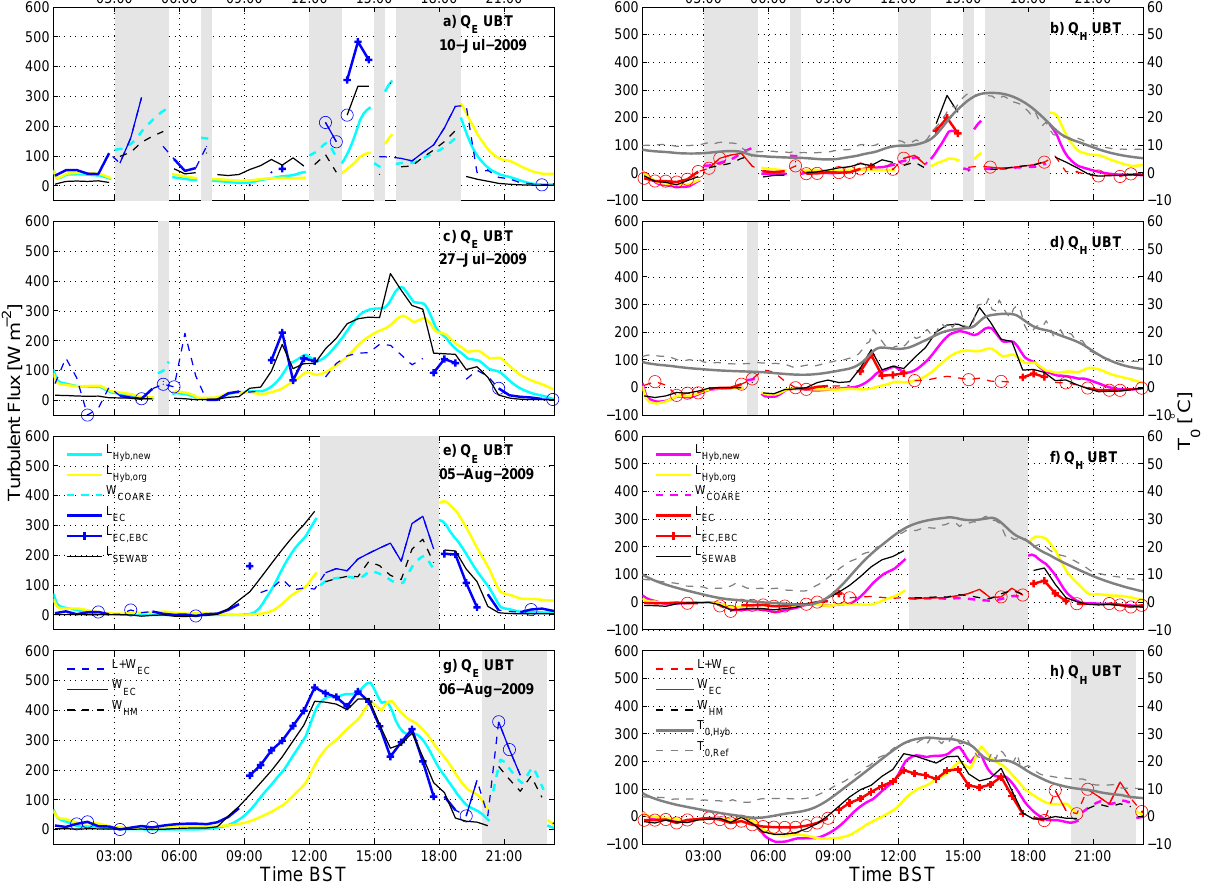
Fig. 6. Model results for the modified Hybrid at UBT for 10 July 2009 (a–b) , 27 July 2009 (c–d) , 5 August 2009 (e–f) and 6 August 2009 (g–h) . Left column: latent heat flux ( Q E ); right column: sensible heat flux ( Q H ) and surface temperature T 0 [ ◦ C]. L and W refer to “land” and “water” as origin of the fluxes. L+W is the complete available time series. The subscripts Hyb,mod and Hyb,org refer to fluxes from the modified and original Hybrid and COARE are fluxes from the lake derived by TOGA-COARE whereas SEWAB is a SVAT model and HM refers to a hydrodynamic multi-layer lake model after Foken (1984) and Panin et al. (2006). EC and EC,EBC refer to measurements by eddy covariance method where in the latter the energy balance has been closed by distributing the residual according to Bowen-ratio (this requires good data quality and fluxes and can only be done for fluxes that are attributed to land). The circles indicate poor data quality of the EC system according to Foken et al. (2004). Gray shading indicates times where the flux footprint of UBT was over the